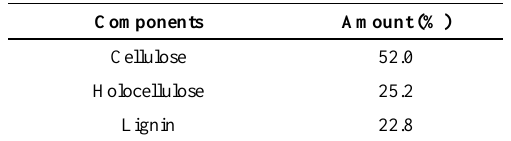
Table 2. Cellulose, hemicellulose, and lignin contents from OPT